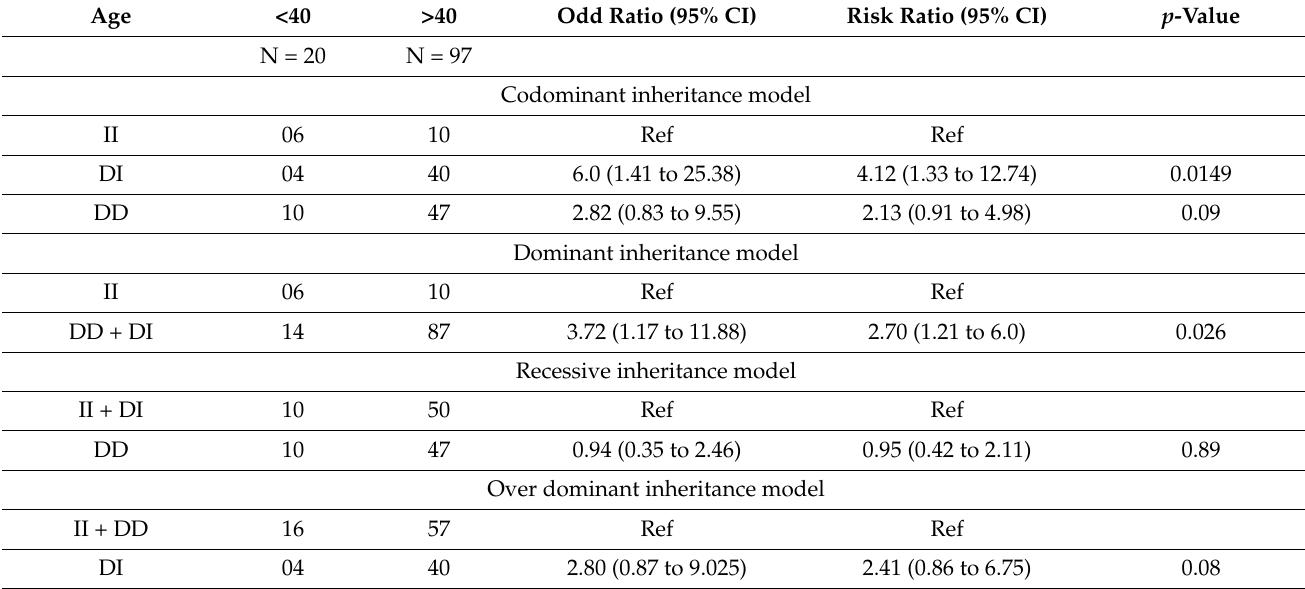
Table 6. Statistical comparisons ( p -values) of ACE2-rs4646994 I/D genotypes with age of COVID-19 severity.